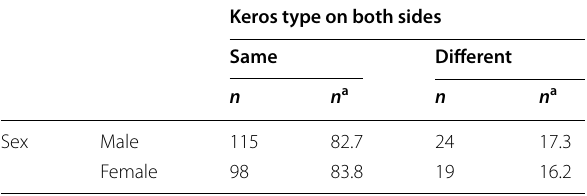
a Column percentages